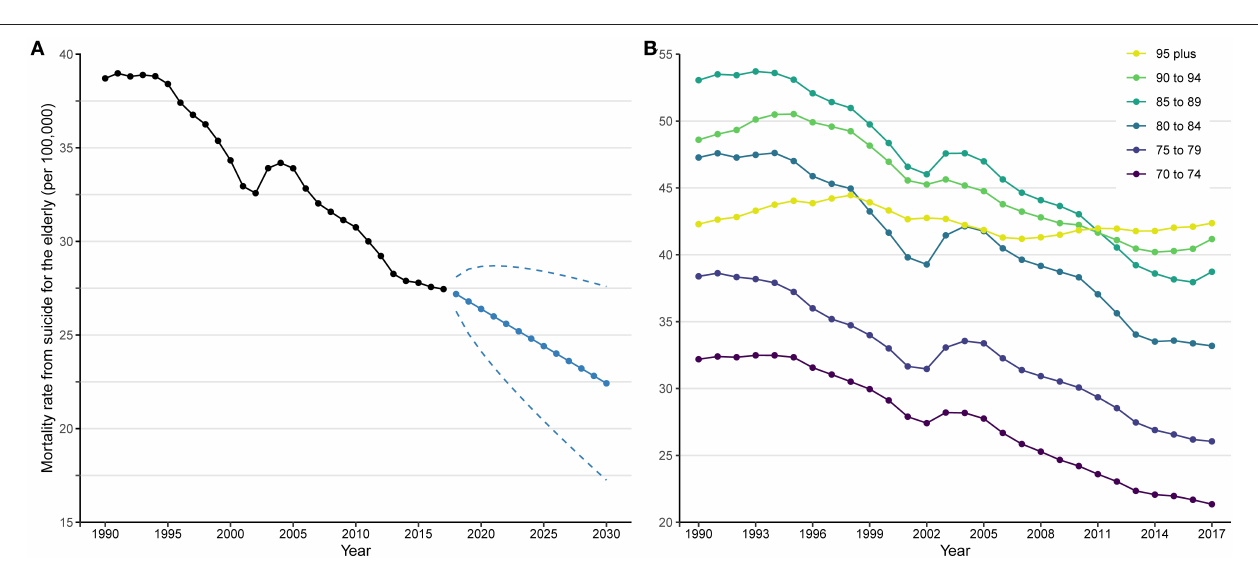
rates increased significantly, with the largest in Armenia, South Korea, Ecuador, Dominican Republic, and